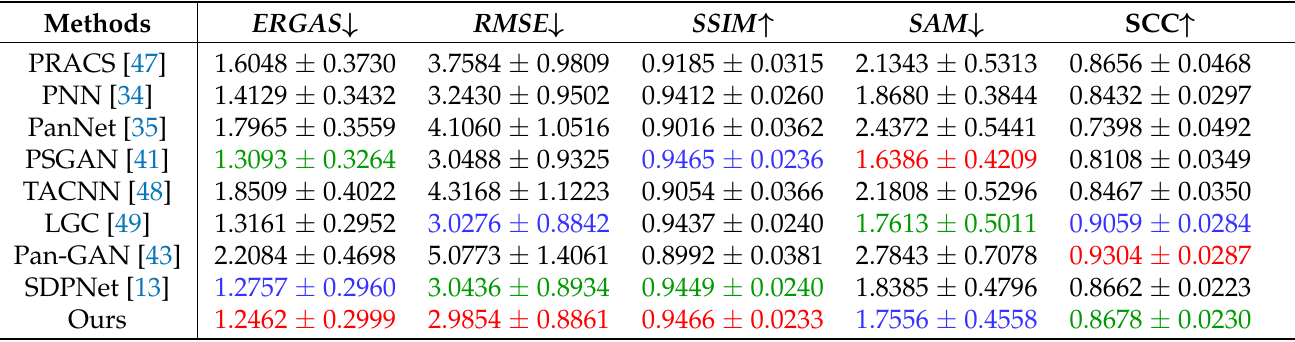
Figure 7. Qualitative comparison of CPNet with other eight pan-sharpening methods on the data from the QuickBird data set. Table 2. The quantitative comparisons of different pan-sharpening methods on eighty satellite image pairs from QuickBird (values in red, blue, and green indicate the best, the second best, and the third best value,